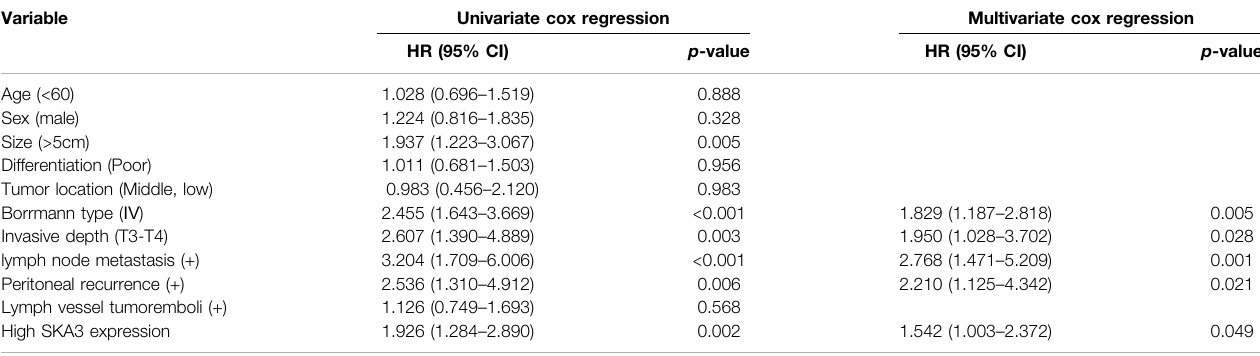
TABLE 2 | The univariate and multivariate analyses of factors associated with overall